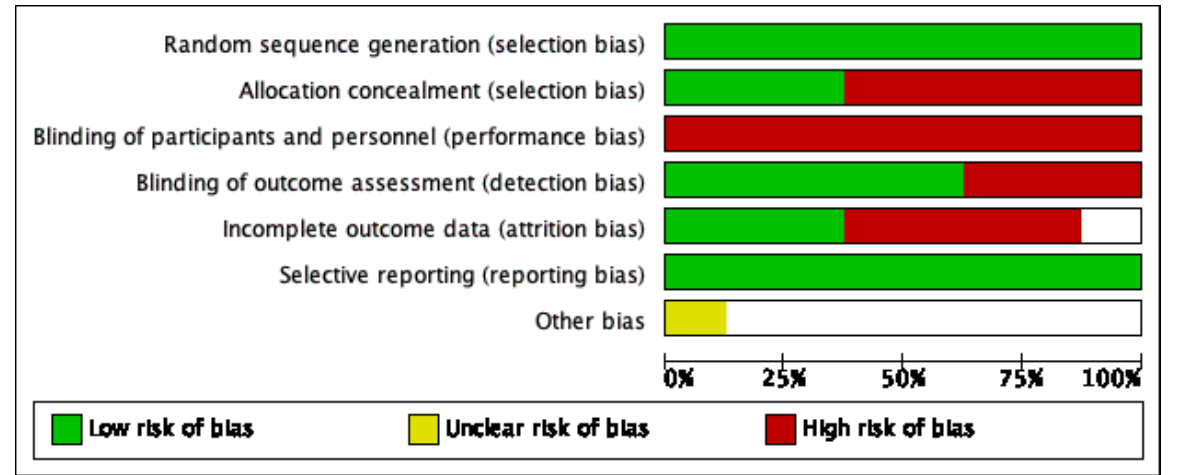
Figure 2. Risk of bias assessment of the included studies.